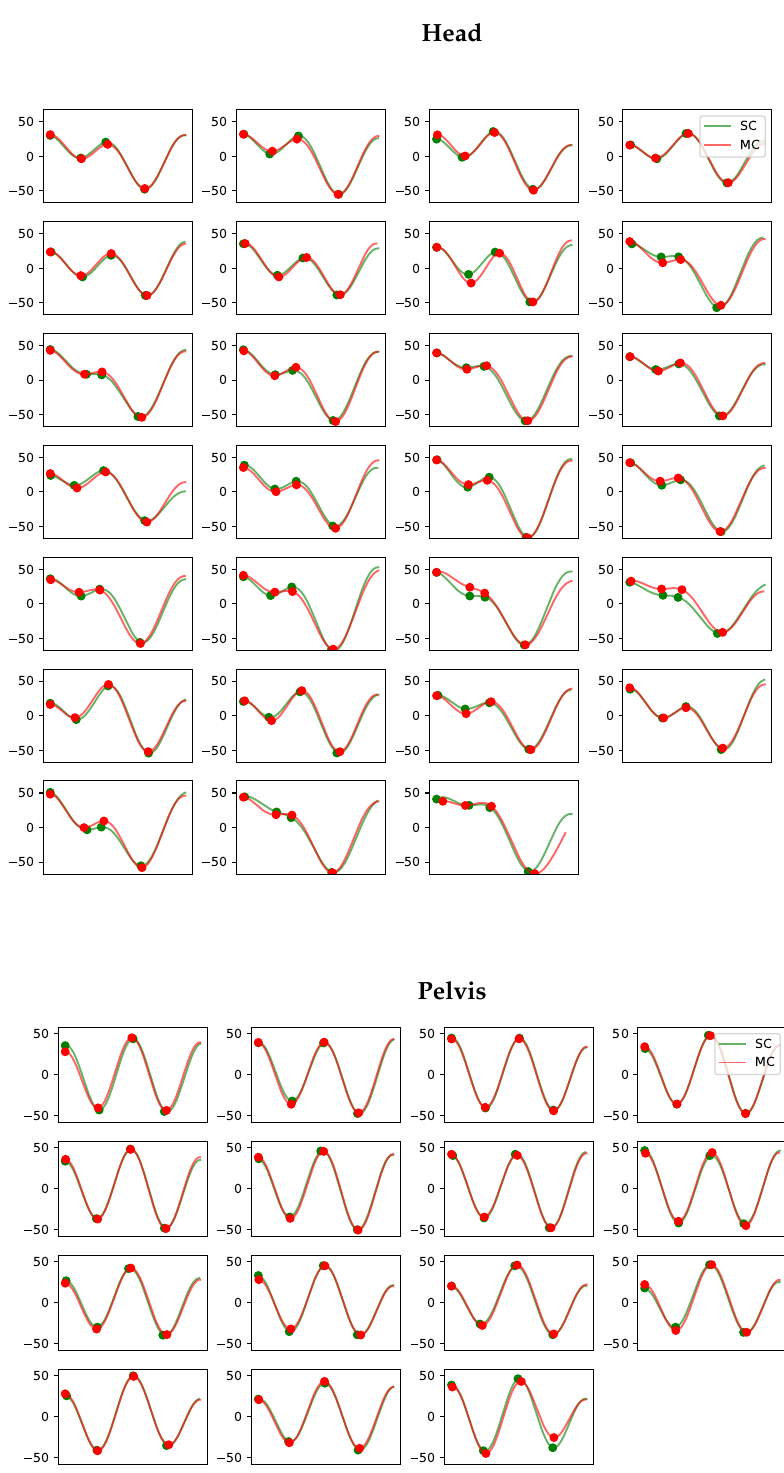
Figure 4. Example of the vertical displacement signal per stride for the head and pelvis for horse 11. Each subplot contains the matched stride segments for the markerless single-camera system (SC) in green and the multi-camera marker-based motion capture system (MC) in red. The y-axis shows the vertical displacement in millimetres. The four dots on each curve indicate the positions of the two peaks and two valleys extracted using the approach in Section 2.6.2. We observe that despite the high variability in curve shape between strides, there is a notable resemblance between the two